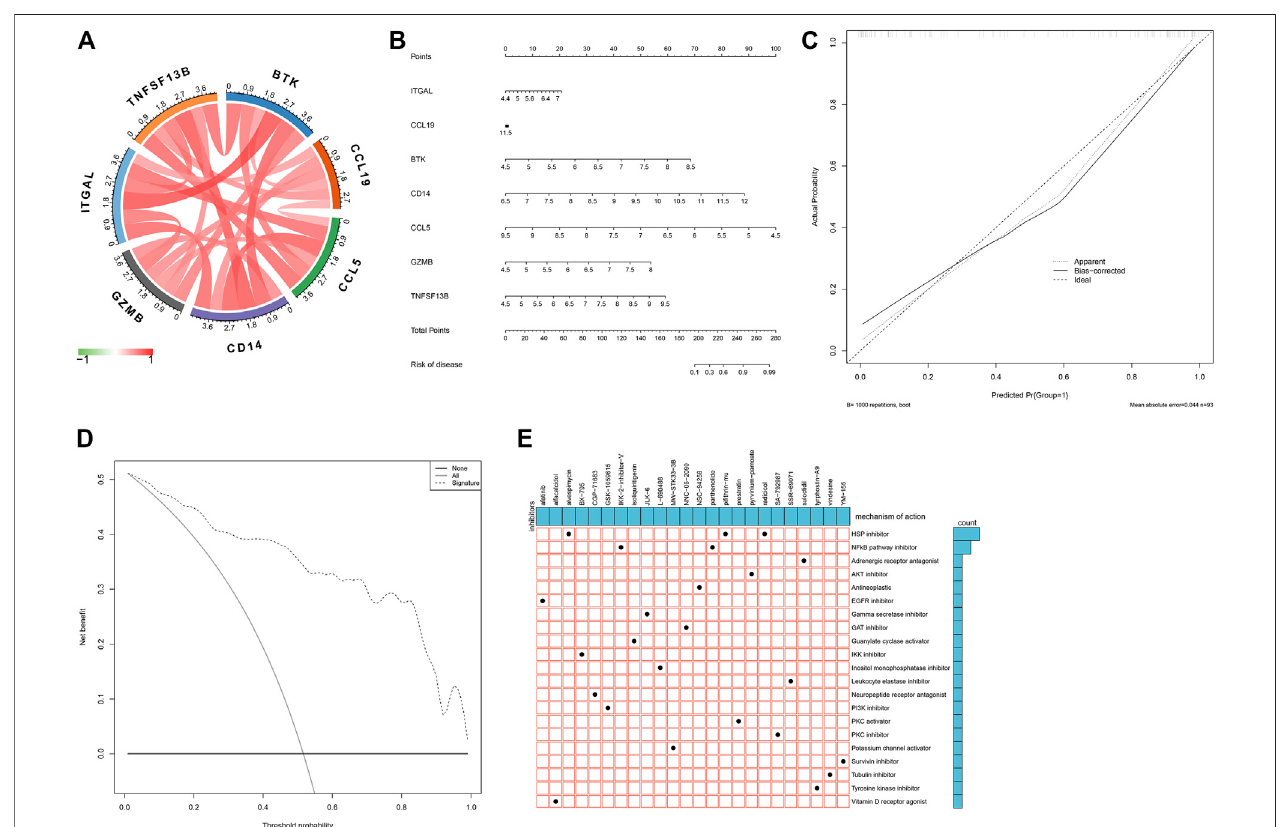
FIGURE 7 | Establishment of a characteristic gene-based nomogram and selection of potential small molecular compounds. (A) Interactions between characteristic genes at the molecular level. (B) Establishment of a nomogram integrating characteristic genes for predicting atherosclerotic plaque progression. In the nomogram, each variable corresponds to a score, and the total score can be calculated by adding the scores for all variables. (C) Calibration curve estimates the prediction accuracy of the nomogram. (D) Decision curve analysis shows the clinical bene fi t of the nomogram. (E) The mechanisms of action shared by small molecular compounds based on CMap